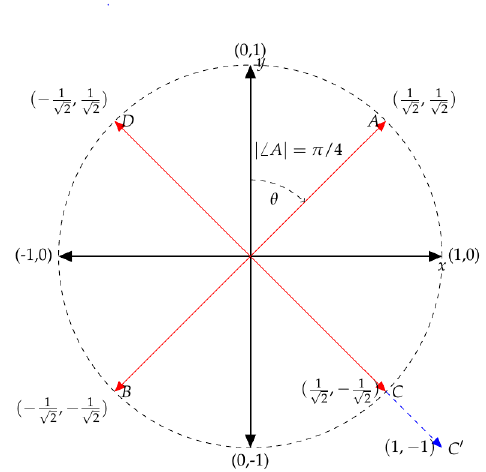
Figure 7. Panning of two tracks, represented as a 1-sphere. The panning mix is determined by the angle θ with r pan acting as a scaling variable, adjusting the overall width of the mix. For example, C (cid:48) is a wider version of C